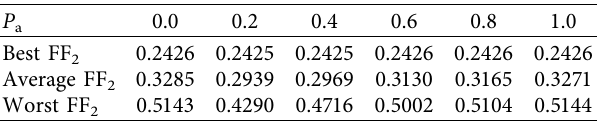
Table 3: The obtained results by ICOA for Case 2 of the IEEE 69- bus distribution network.